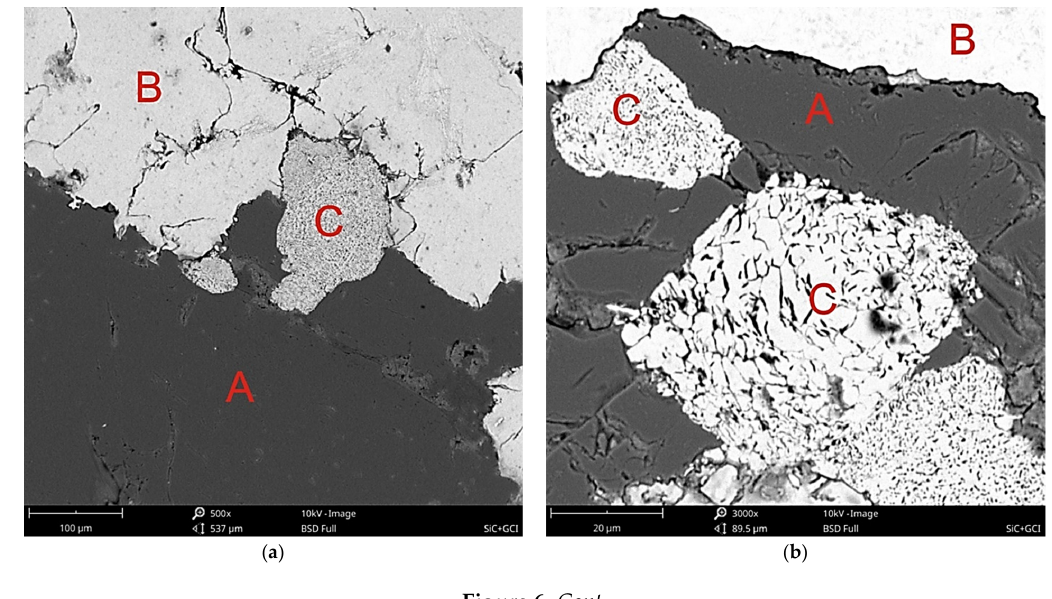
Table 4. The result of the EDS point analysis (marking points according to Figure